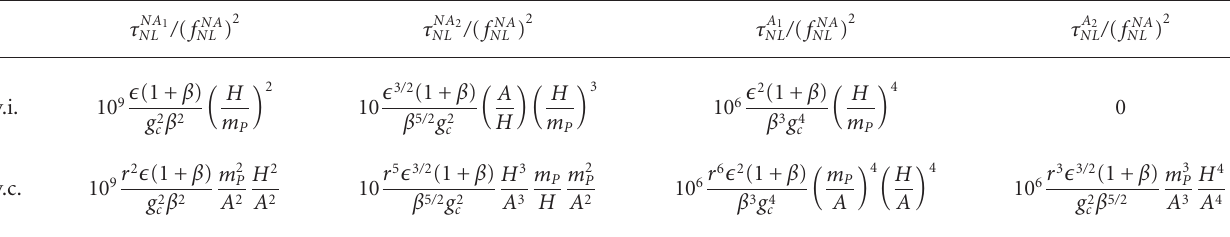
) 2 in di ff erent / ( f NA NL NL